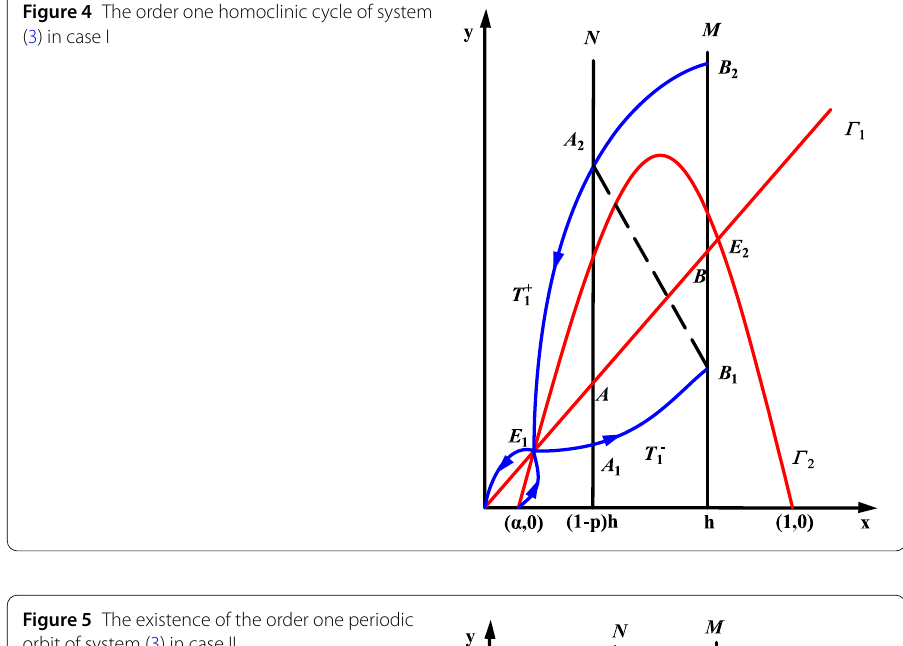
Figure 5 The existence of the order one periodic orbit of system (3) in case